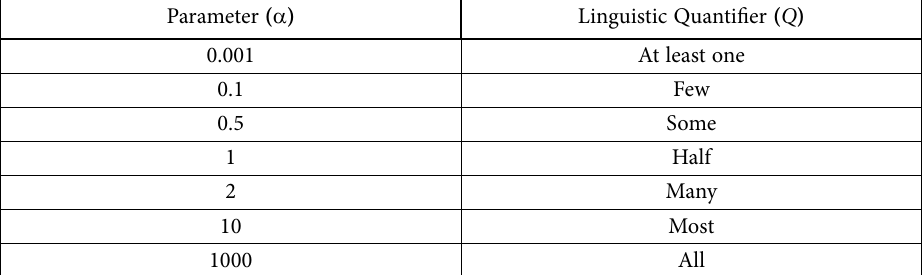
Table 3. Definition of various linguistic quantifiers, based on (Boroushaki & Malczewski, 2008) Parameter ( α